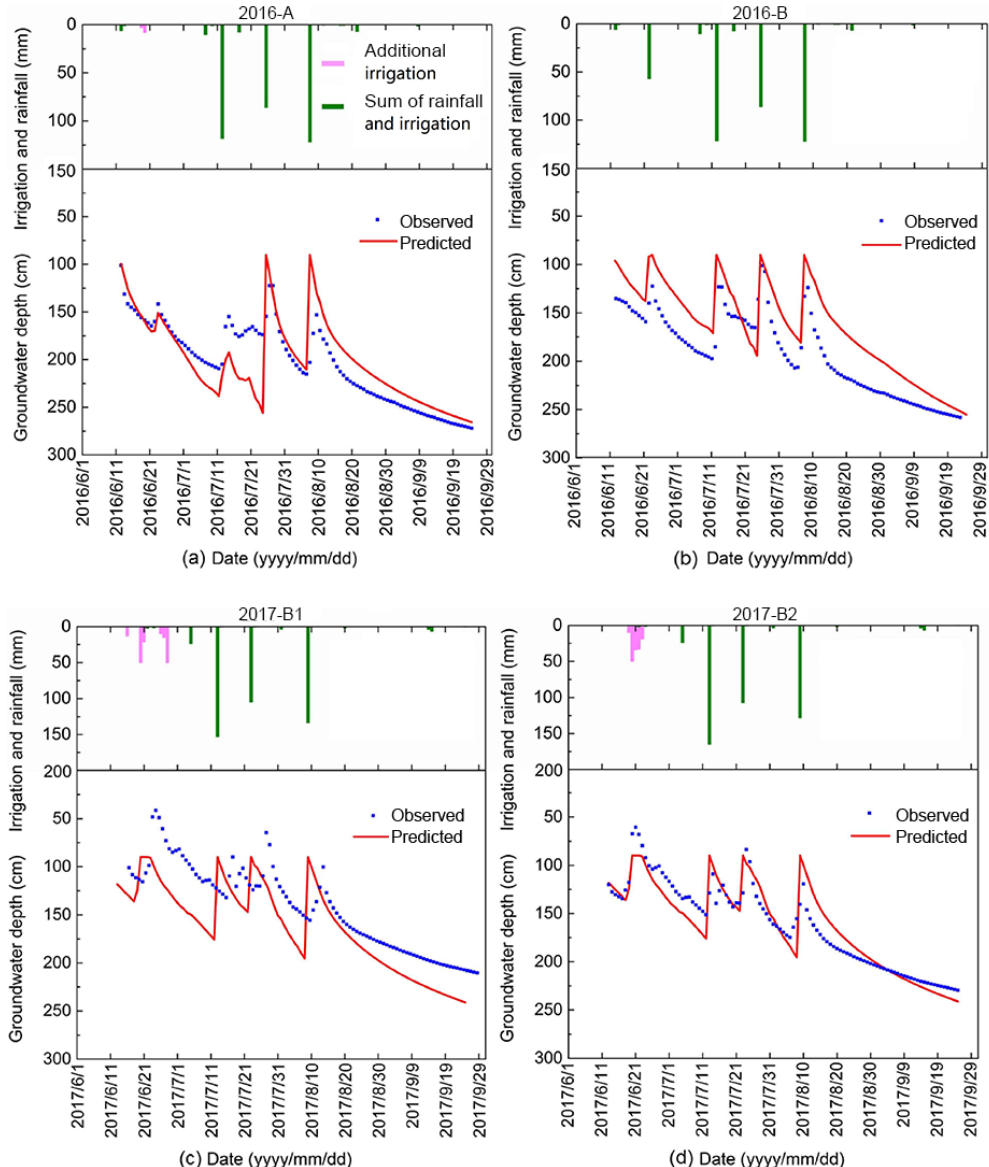
Figure 4. Simulated and observed groundwater depth during the growing period for the Fenzidi experimental fields in the Hetao irrigation district: (a, b) calibration in 2016 and (c, d) validation in 2017. (Note: additional irrigation means the irrigation recharge from the adjacent field which leads to the water table rise and is not